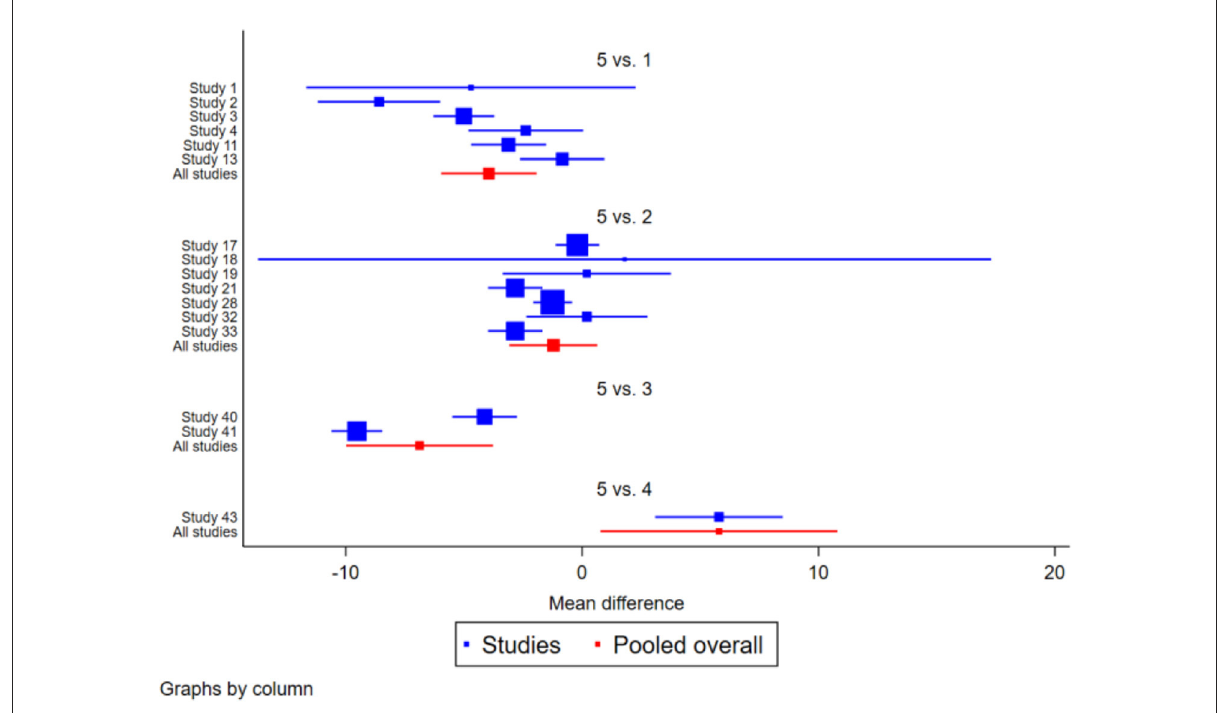
FIGURE7 Forest plot of the effect of traditional Chinese physical exercise therapy on BBS in the